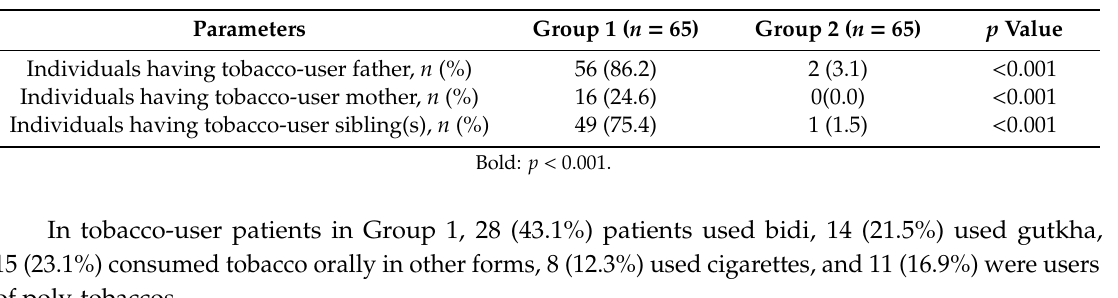
Table 2. Tobacco usage among family